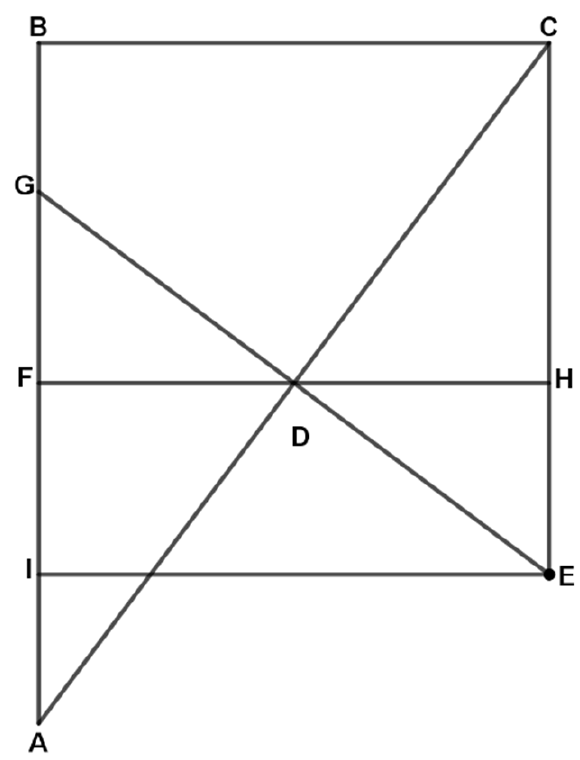
Figure 4. Graphical representation of Mydorge’s Proposition II 17.